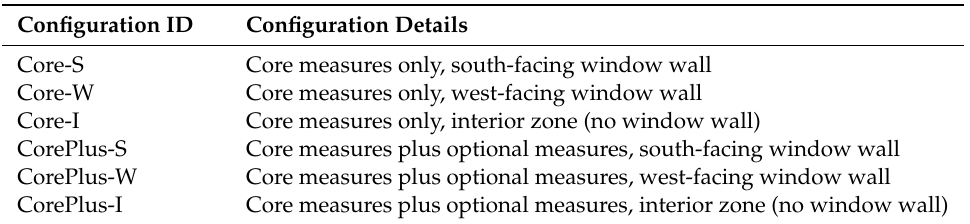
Table 3. Tenant fit-out configurations tested.